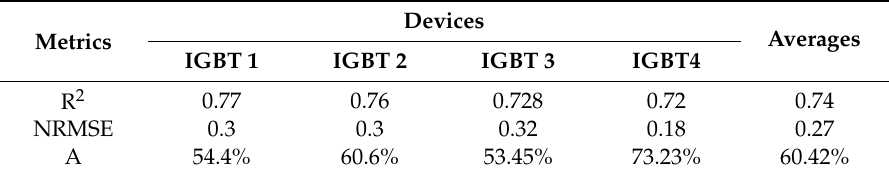
Table 2. Proposed approach